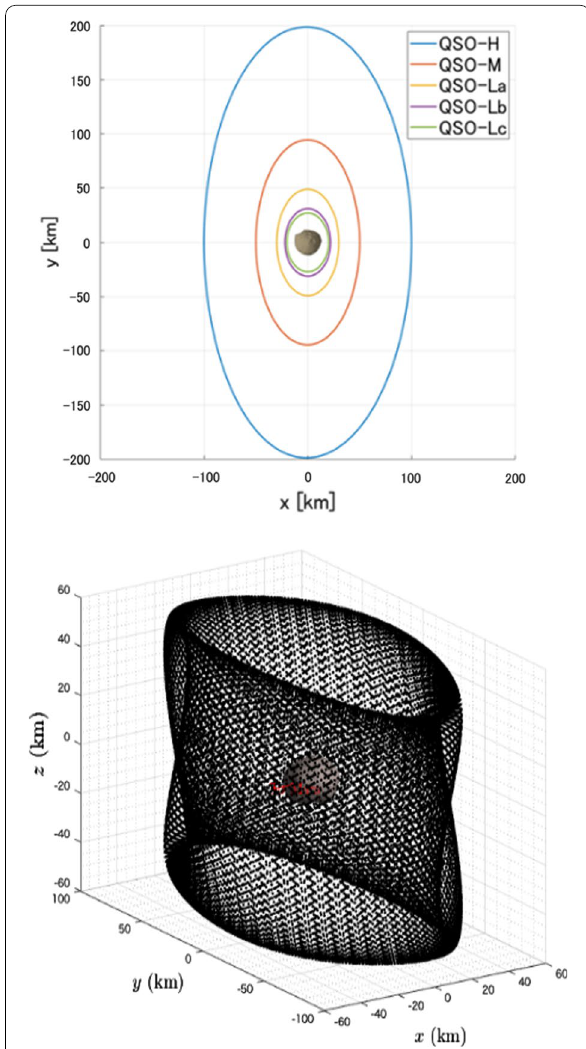
Fig. 3 Planned observational orbits around Phobos. Quasi‑satellites orbits (QSOs) are drawn in the Phobos fixed frame with Phobos at the center taking the xy‑plane and the x‑axis direction to be the Phobos orbital plane and the opposite direction to Mars, respectively. Top: QSOs confined in the xy‑plane. Bottom: An example of 3D‑QSO trajectory for the case taking effective orbital radius same as QSO‑M and inclination of